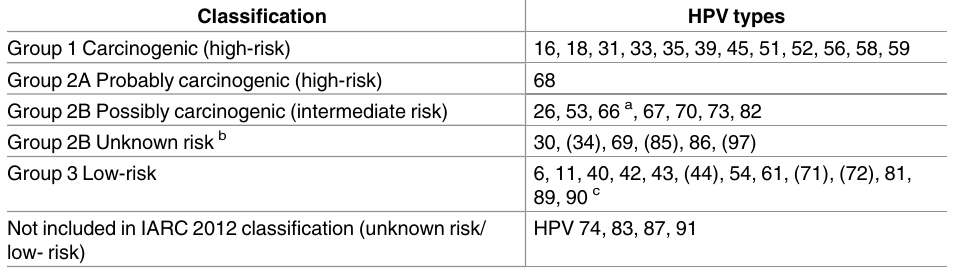
Table 1. Risk classification of